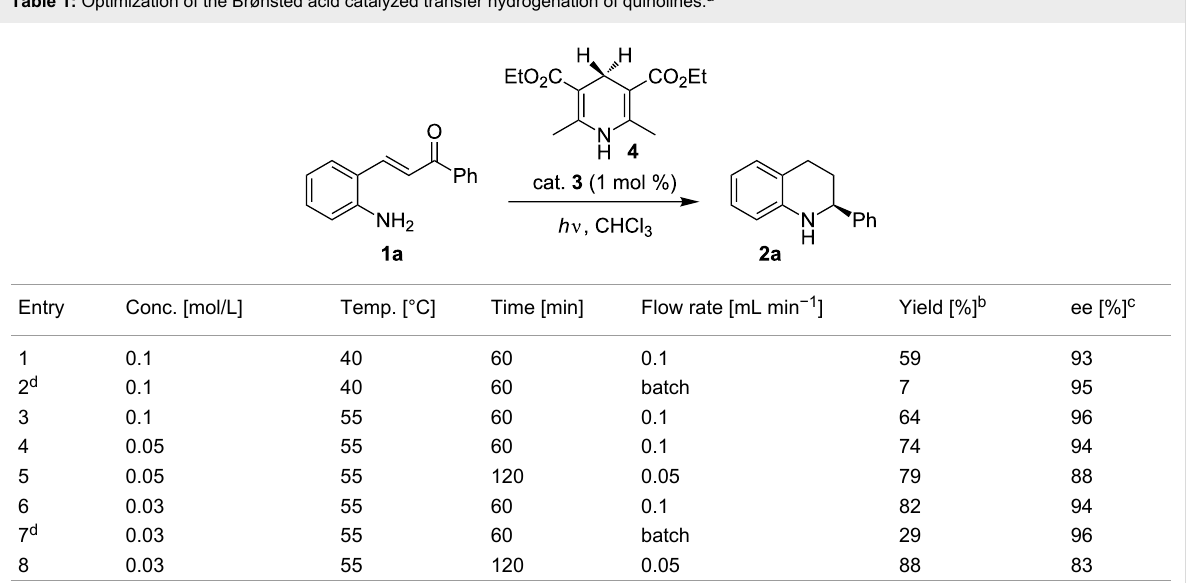
Table 1: Optimization of the Brønsted acid catalyzed transfer hydrogenation of quinolines.